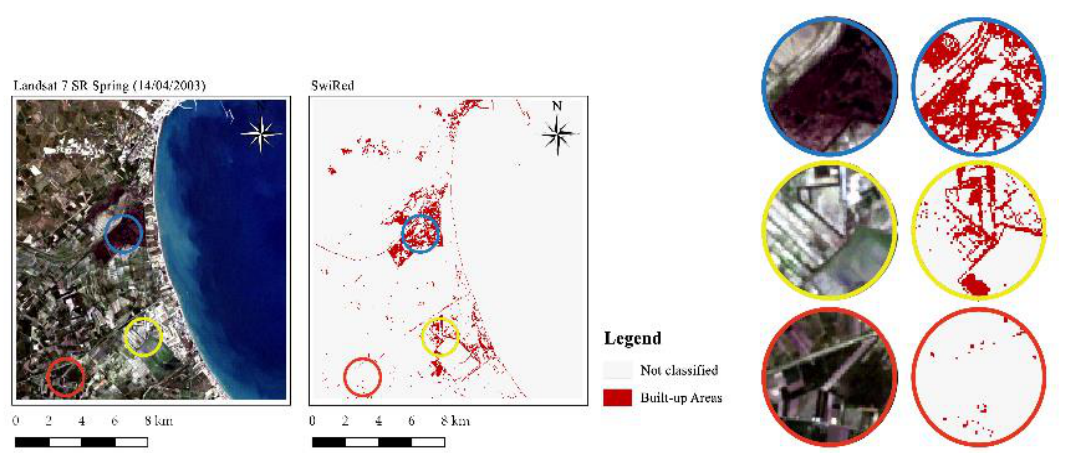
Figure 11. SwiRed index (SwiRed) classification outcome for Landsat 5 (image acquired on 5 October 2011). On the right, zoomed images with some misclassifications.